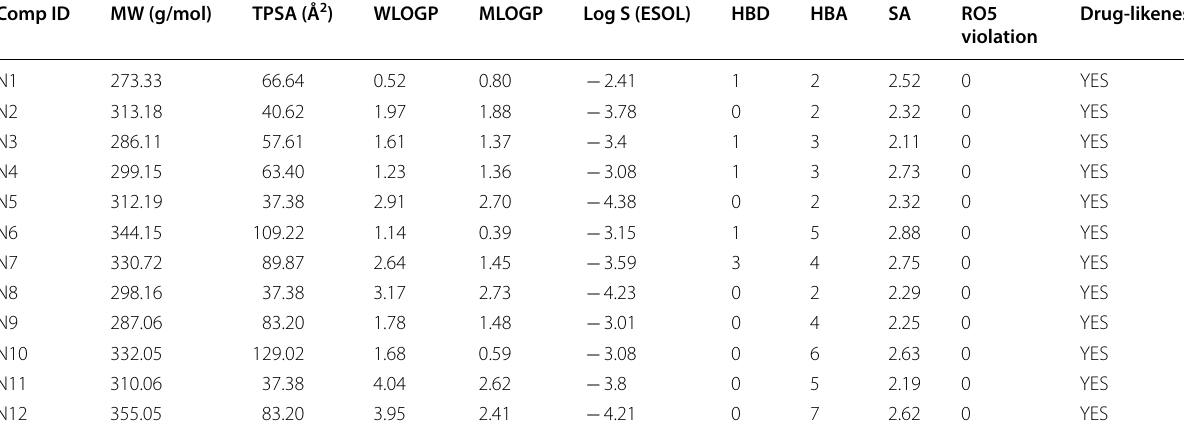
Table 13 Predicted drug-likeness properties of the newly designed